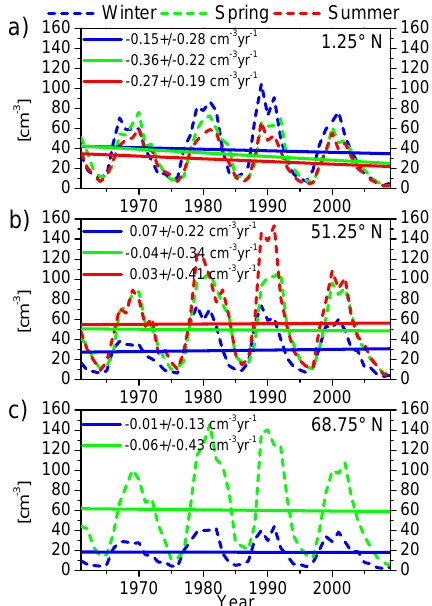
Figure 3. Long-term variations (dashed lines) and corresponding Figure 4. Long-term variations (dashed lines) and corresponding linear trends (solid lines) in the seasonally averaged nighttime mean linear trends (solid lines) in the seasonally averaged nighttime mean concentration of the OH ∗ peak due to increase in GHGs in the concentration of the OH ∗ peak due to Lyman- α flux variability in v = 6 v = 6 CTM in low (a) , middle (b) , and high (c) northern latitudes for win- low (a) , middle (b) , and high (c) northern latitudes for winter (blue ter (blue lines), spring (green lines), and summer (red lines). lines), spring (green lines), and summer (red